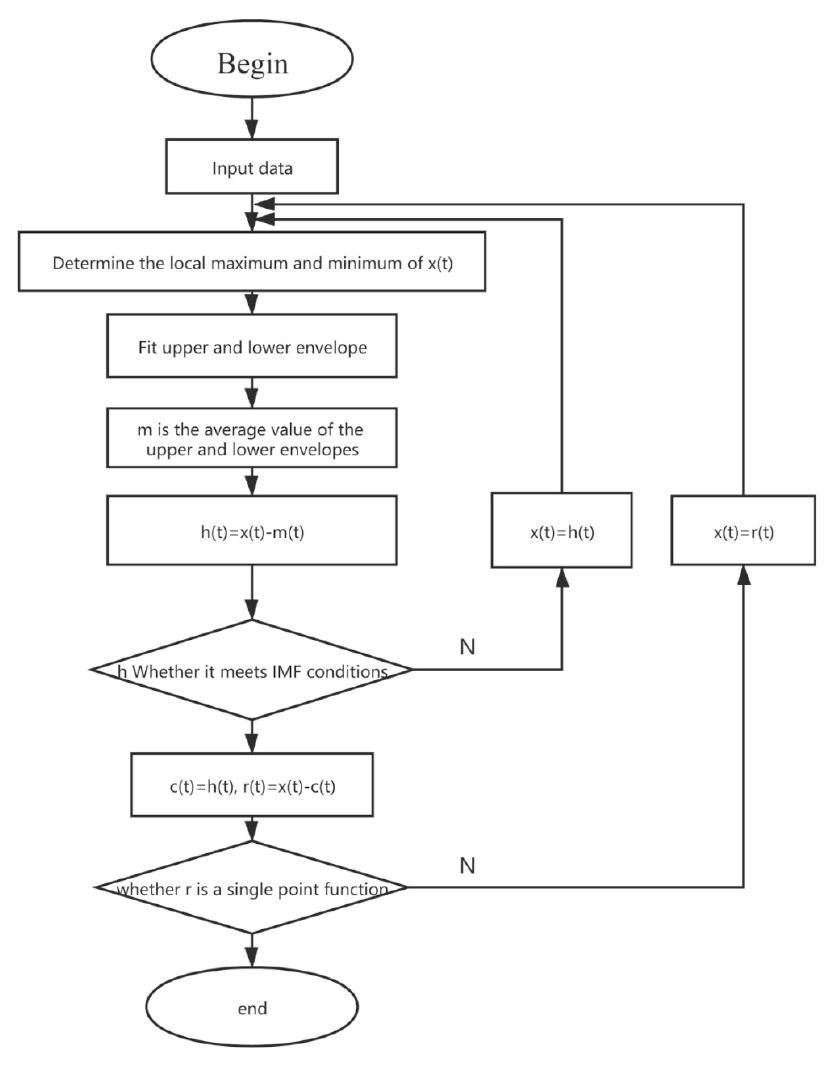
Figure 4. The EMD flowchart.